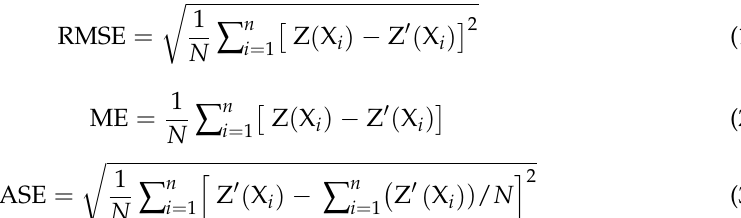
where N is the number of known samples, the actual value is Z(X i ), and the estimated value is Z (cid:48) (X i